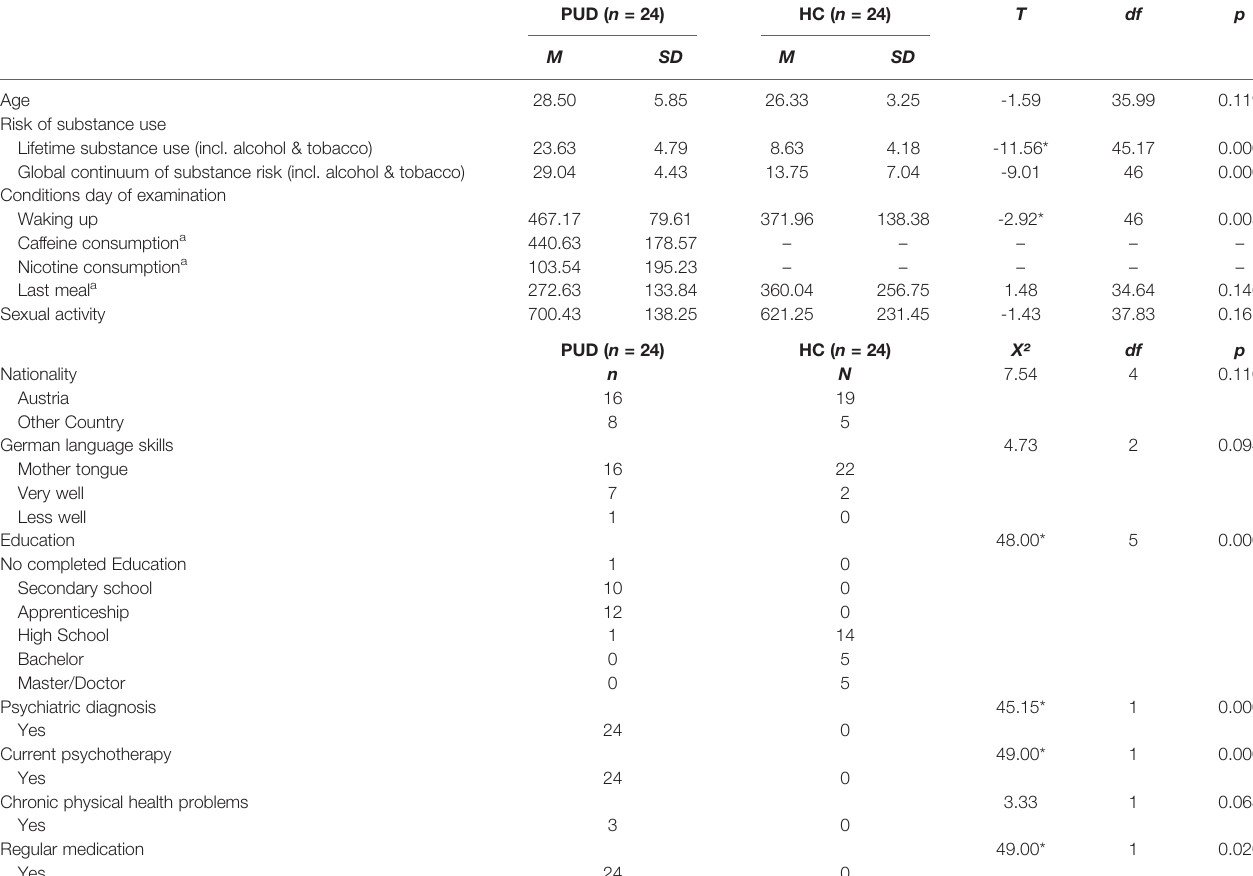
TABLE 1 | Group differences in demographic data and conditions prior to investigation.